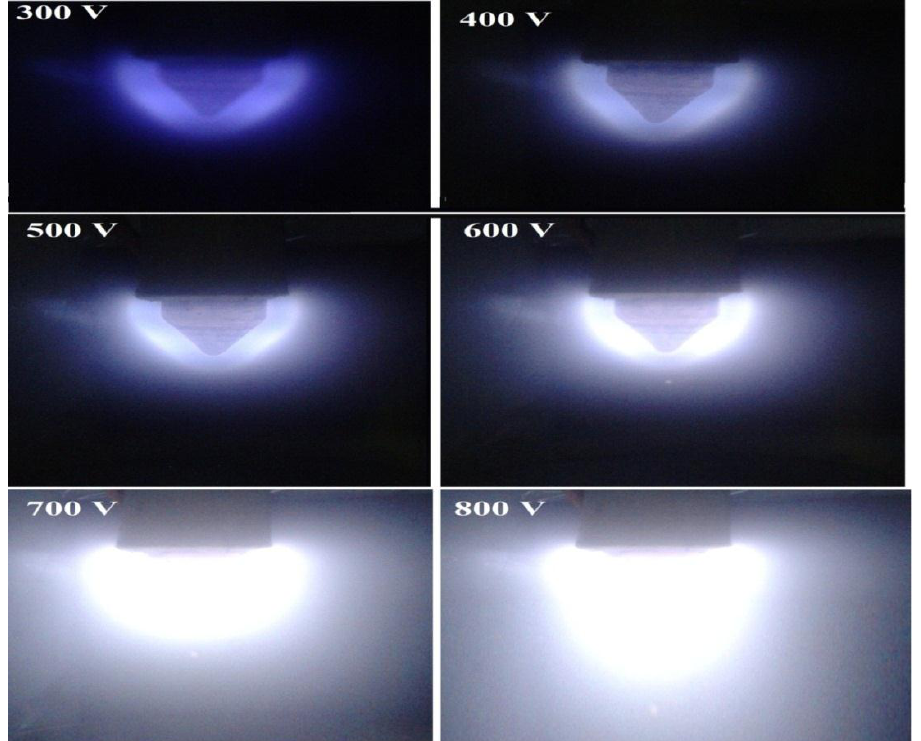
Fig.13: Image during formation of glow discharge as a function applied